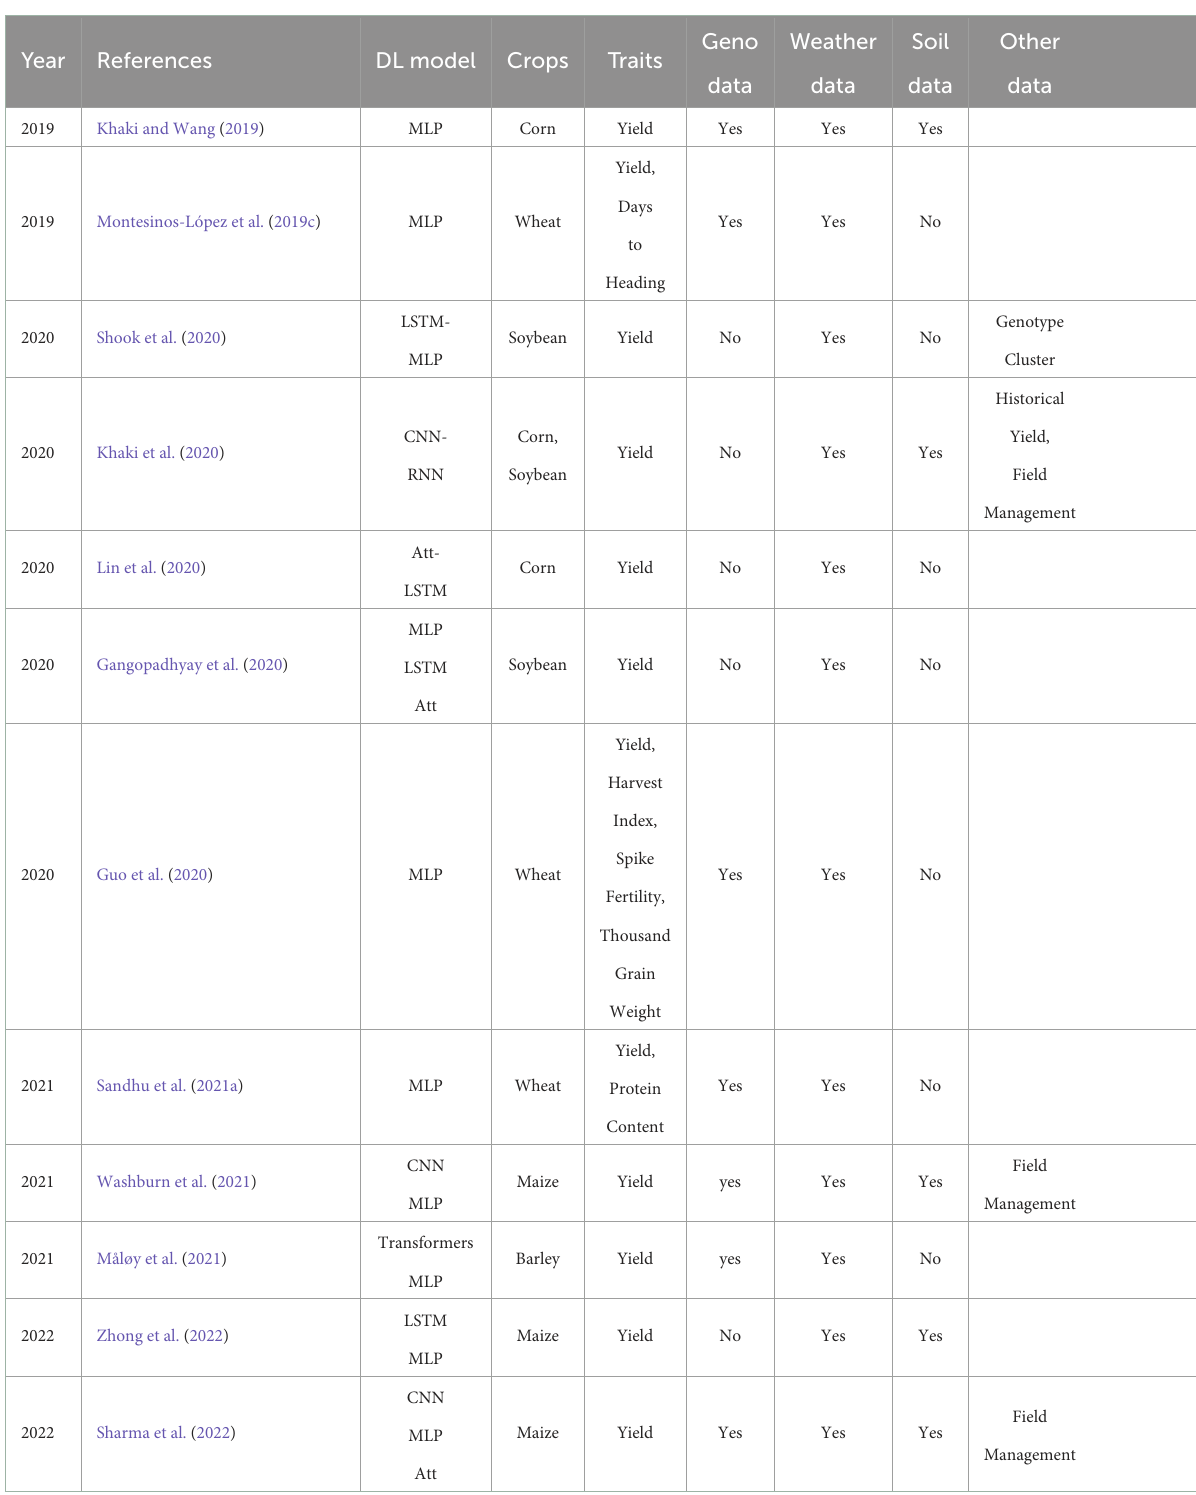
TABLE 3 Papers on multi-environment deep learning